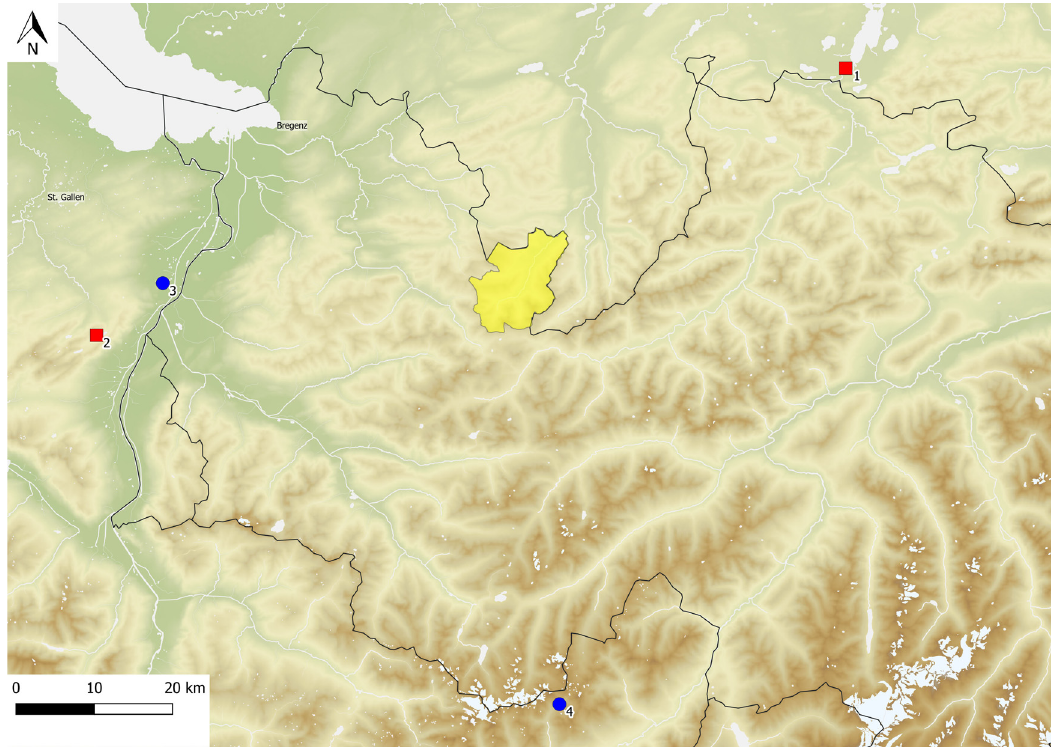
Figure 13: Late Palaeolithic and Early Mesolithic sites 1 Unter den Seewänden, 2 Altwasser Cave, 3 Unterkobel , and 4 Plan da Mattun, L2 . Graphic: C. Posch; data source: Copernicus eu_dem_v11_E40N20 – 25 m